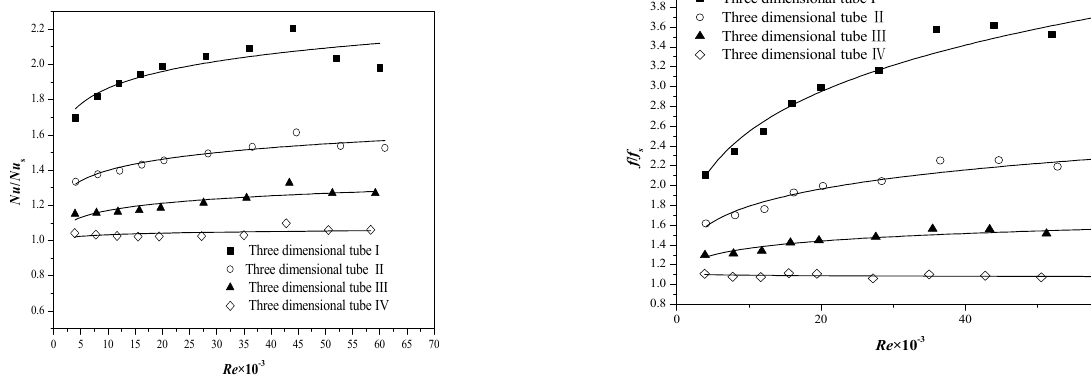
Figure 5. Curves of Nu / Nu s and f / f s outside three-dimensional tube changing with Re .